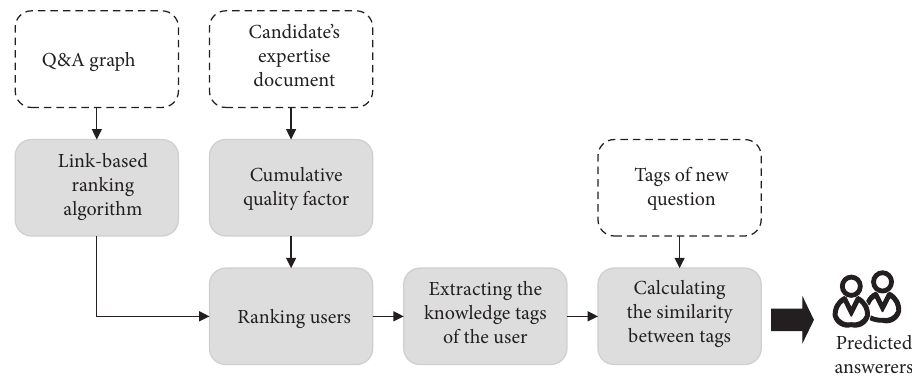
Figure 1: Architecture of proposed expert finding